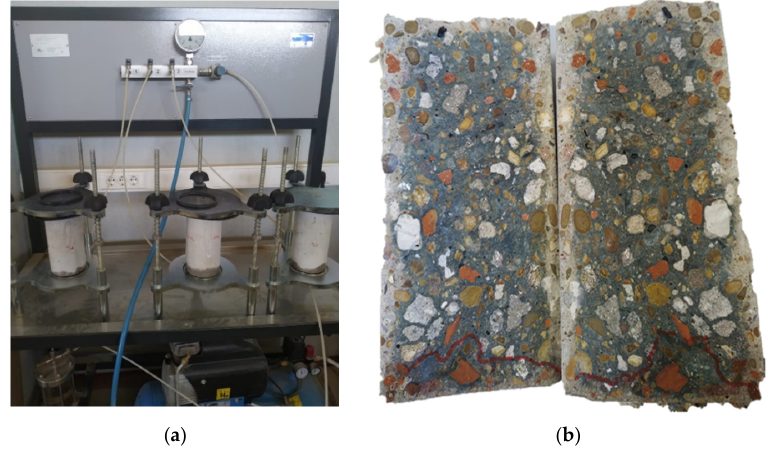
Figure 1. Water penetration under pressure test ( a ) and penetration depth in a specimen ( b ).